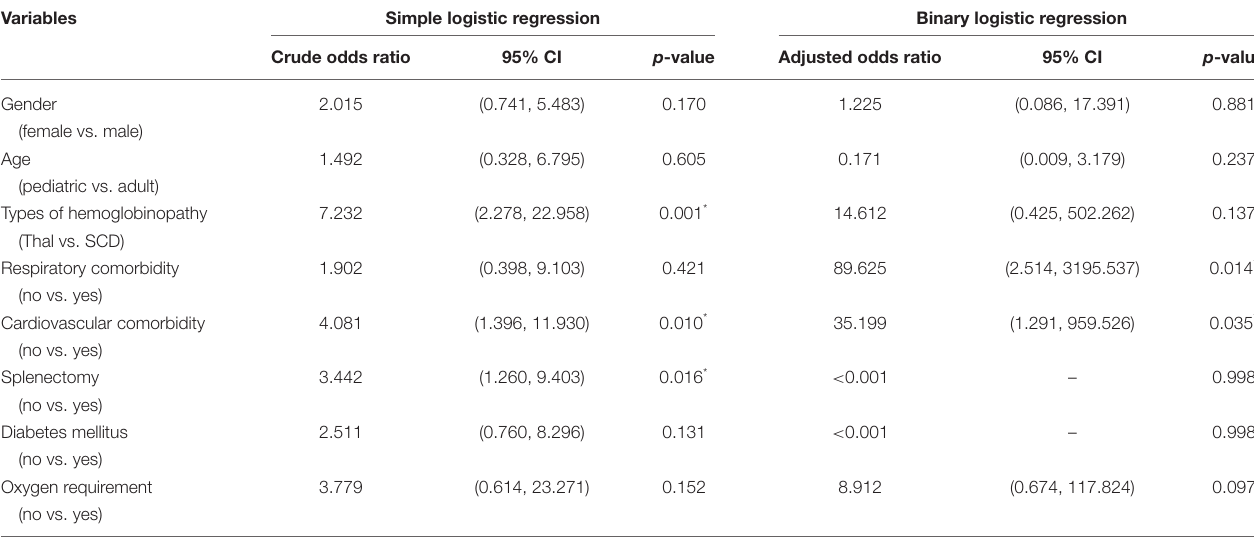
TABLE 5 | Predictors of COVID-19 mortality in patients with hemoglobinopathy.